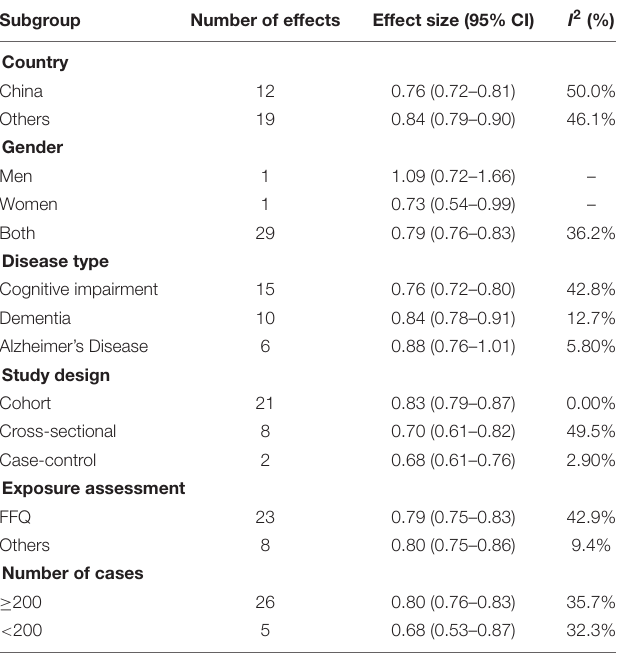
TABLE 2 | Subgroup analyses of relationship between fruits and vegetables intake and cognitive disorders.